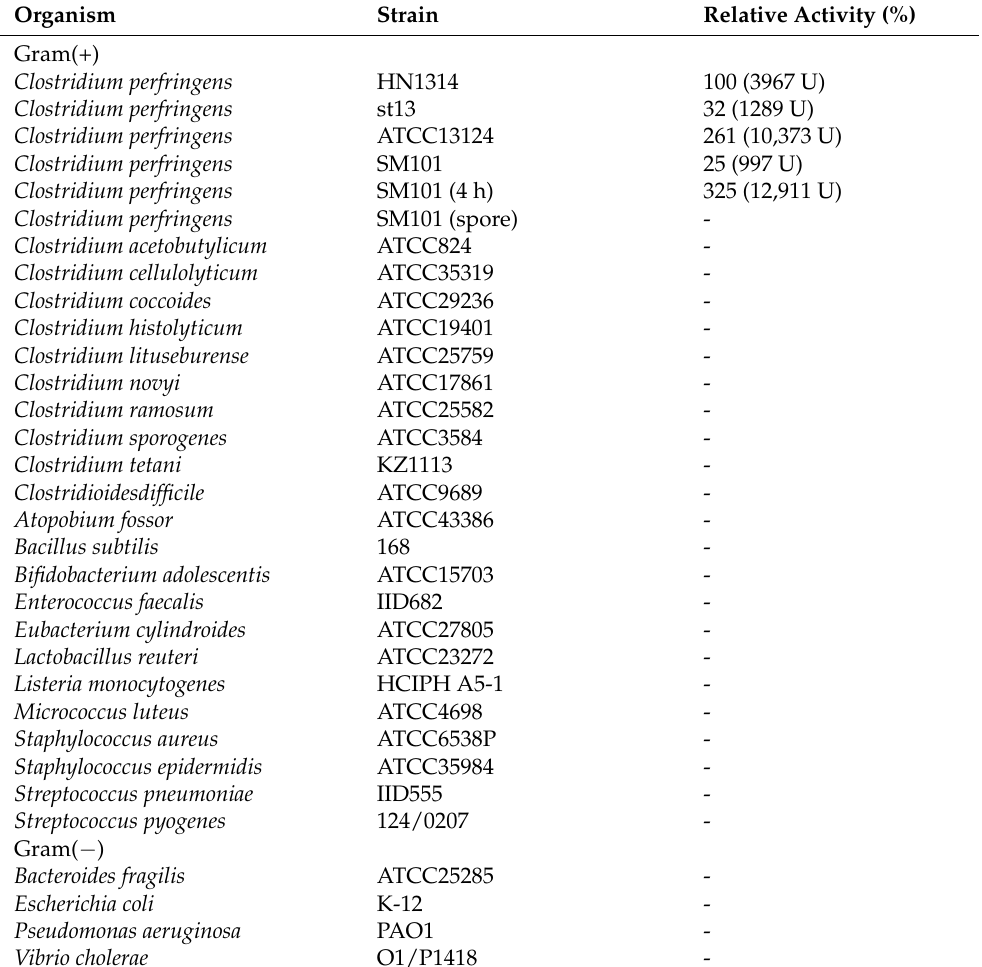
Table 1. Lytic spectrum of